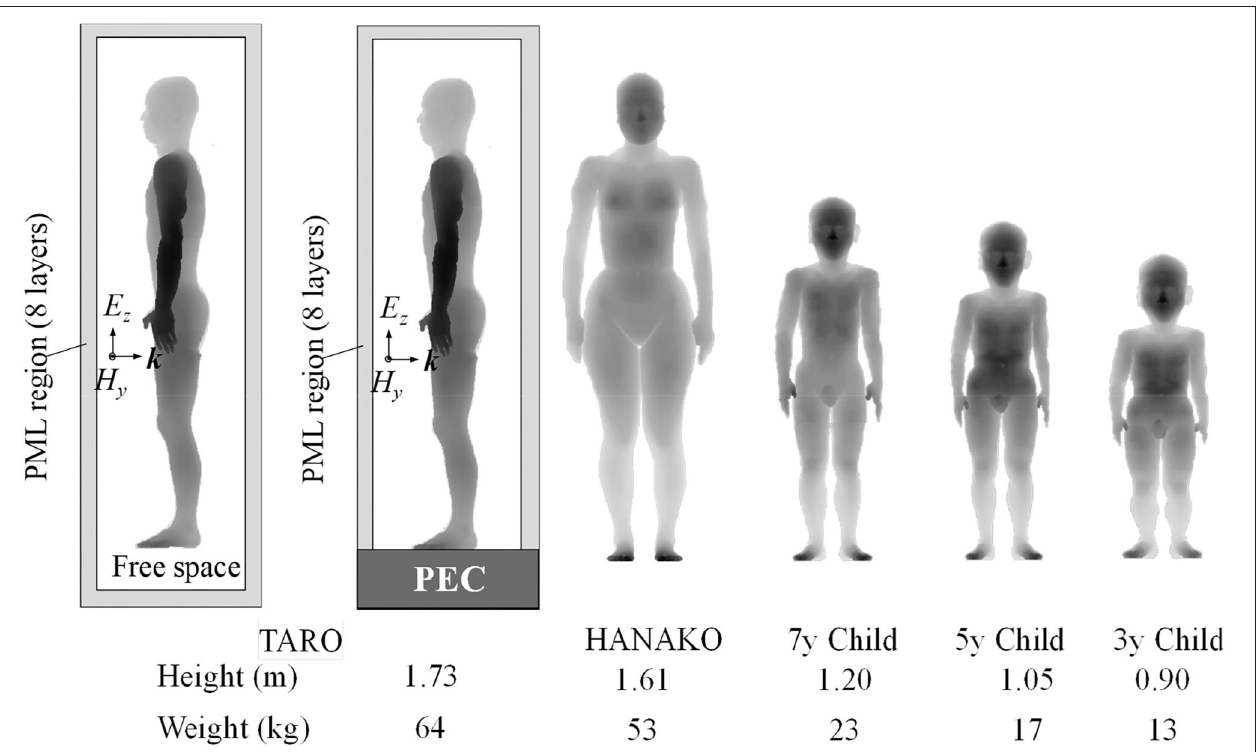
FIGURE 5 | Numerical human models used in simulations. Shading color indicates the distance from the front of analysis domain. Darker for smaller distance.